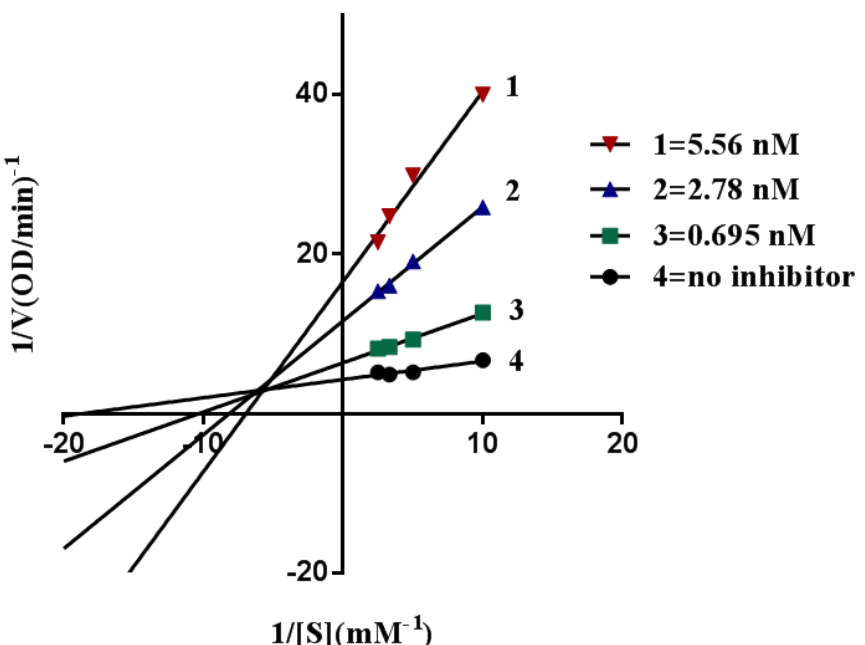
Figure 2. Determination of the inhibitory type of selected compound 8q on AChE. Merged Lineweaver-Burk reciprocal plots of AChE initial velocity with increasing substrate concentrations (0.1–0.4 mM) in the absence or presence of 8q . Lines were derived from a weighted least-squares analysis of data points.